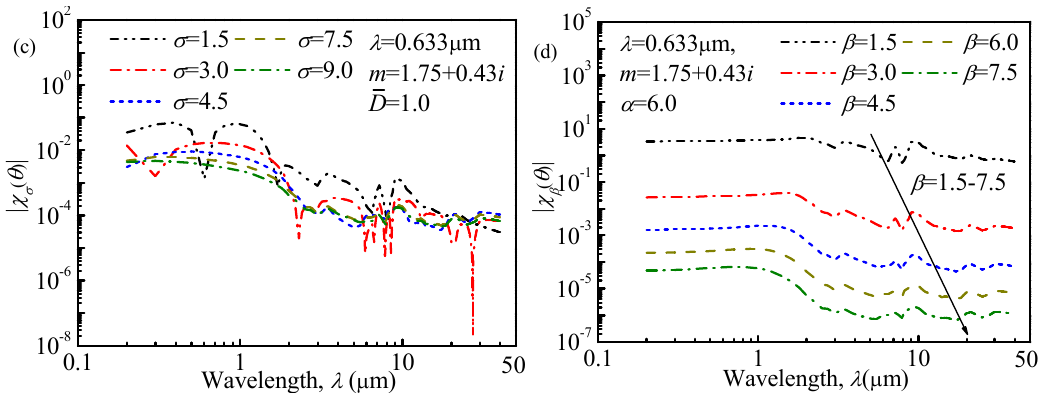
Figure 2. Sensitivity analysis of spectral transmittance signals to characteristic parameters in ASDs: ( a , c ) for L-N distribution, ( b , d ) for Gamma distribution.